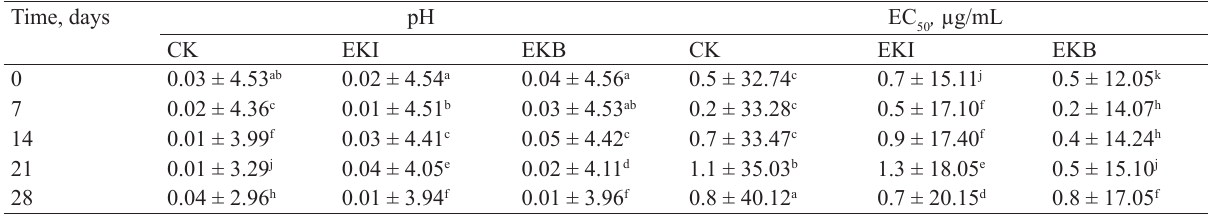
Table 5 pH and DPPH radical scavenging ability of kashk samples during 28-day storage Time, days